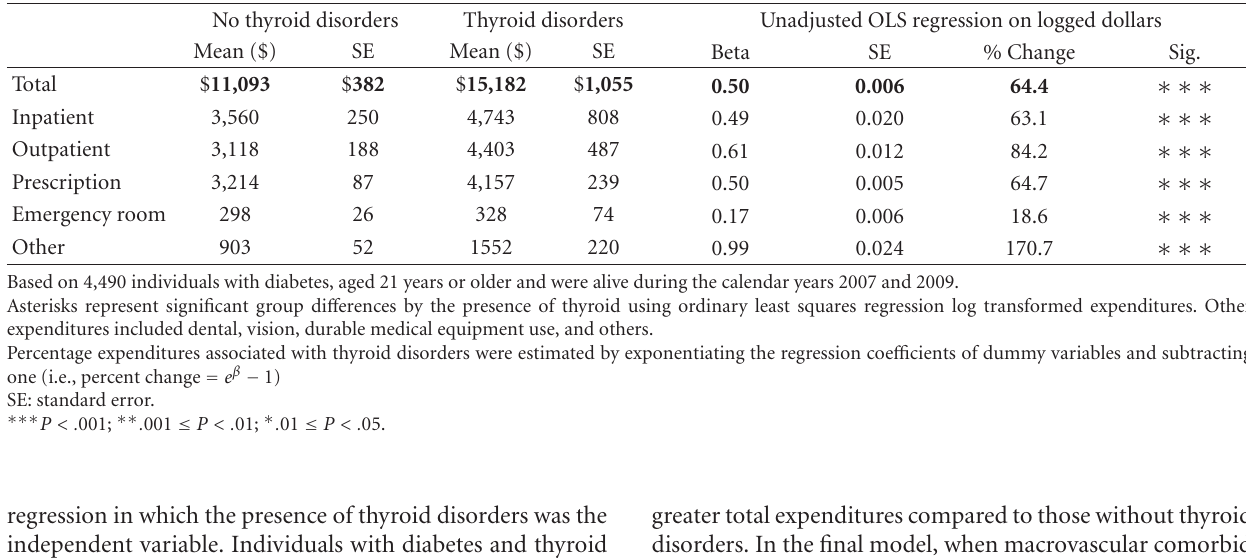
Table 3: Average total and type of expenditures (2009$) by the presence and absence of thyroid disorders individuals with diabetes from the Medical Expenditure Panel Survey, 2007 and